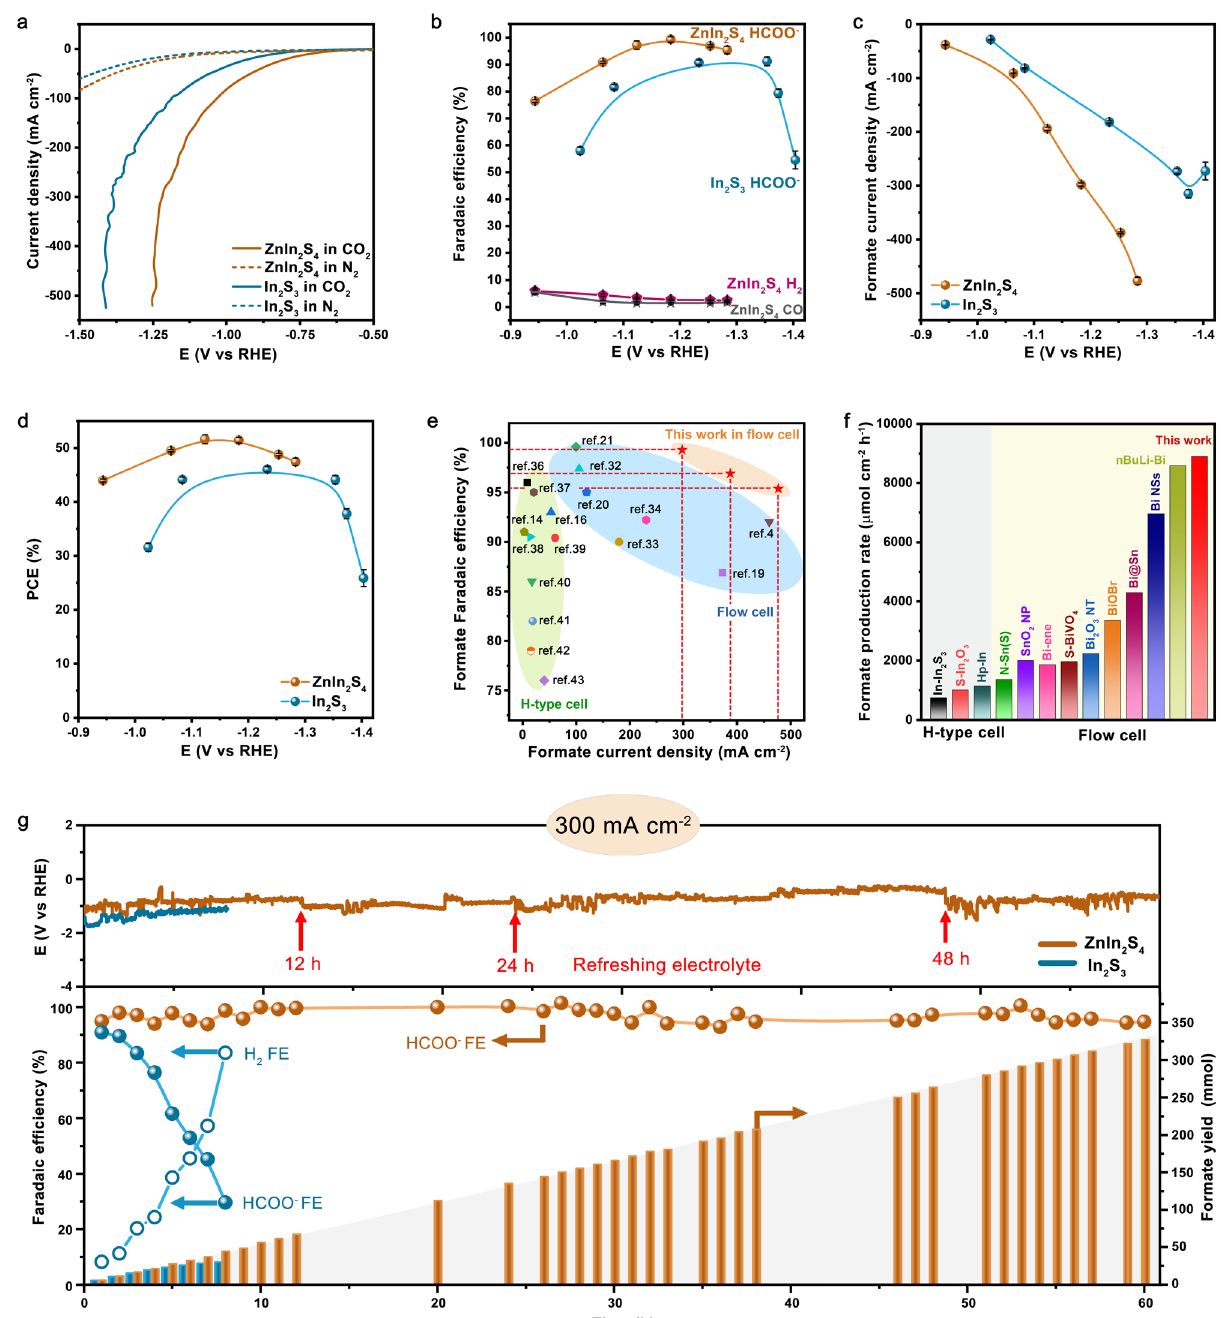
Fig. 2 CO 2 RR performances. a , b The linear sweep voltammetry curves ( a ) and potential-dependent Faradaic ef fi ciencies for products ( b ) on ZnIn 2 S 4 and In 2 S 3 . c , d Partial current density ( c ) and half-cell PCE ( d ) for CO 2 -to-formate conversion on ZnIn 2 S 4 and In 2 S 3 . e , f Comparison of formate partial current densities and FEs ( e ), and formate production rates ( f ) for various catalysts reported under KHCO 3 environments (see Supplementary Table 1 for details). g Stability test of the ZnIn 2 S 4 and In 2 S 3 at 300 mA cm − 2 . The electrolyte was occasionally replaced by new 1 M KHCO 3 solution (red arrows) to recover the ionic concentration and conductivity of the anolyte. The error bars represent the standard deviation of three independent